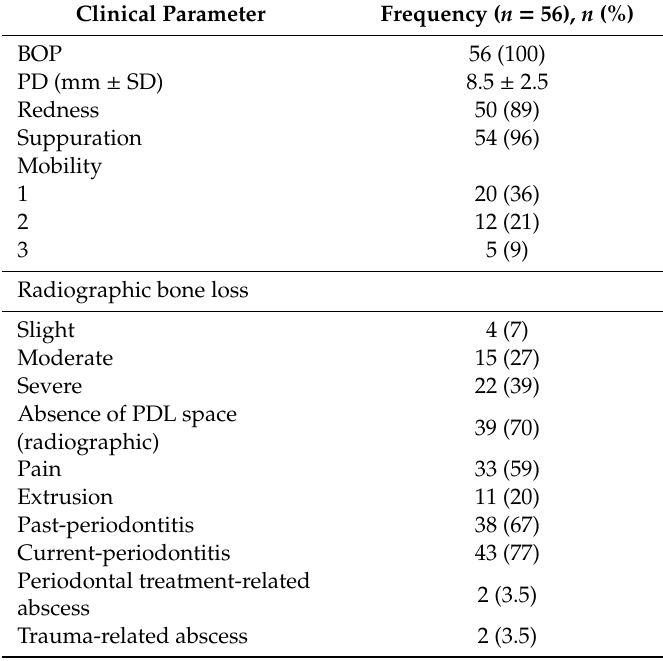
Table 2. Frequencies of various clinical parameters of periodontal